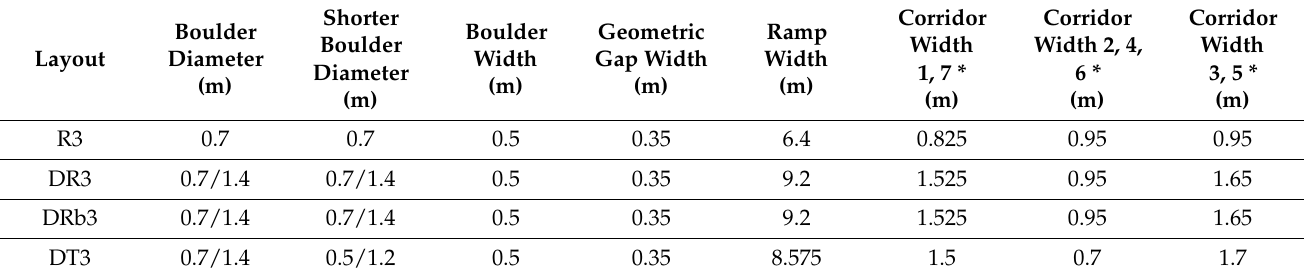
Table 1. Layout parameters of every comparison scheme: rectangular boulder (R3); double rectangu- lar boulder (DR3); double rectangular boulder with small barriers (DRb3) and double trapezoidal boulder (DT3). * The number indicate the corridor